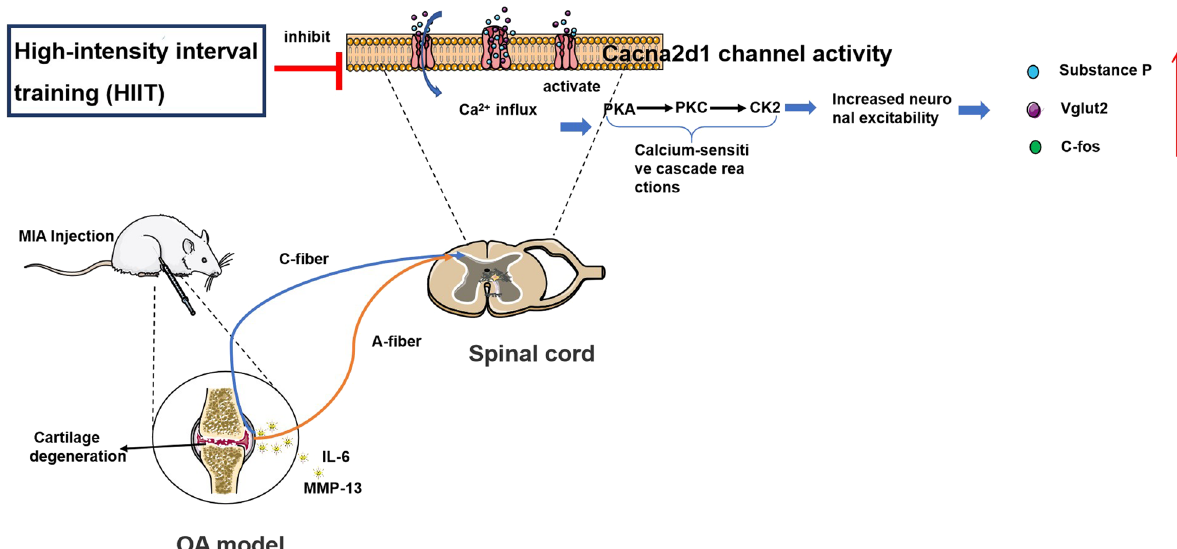
Fig. 4 Schematic illustration showing how intra-articular inflammatory mediators are delivered to the posterior horn of the spinal cord and finally cause pain sensitization. The nociceptive stimuli signals are transmitted to the posterior horn of the spinal cord through A fibers and C fibers, leading to increased Cacna2d1 channel activity. The increased influx of Ca 2 + further triggers a calcium-sensitive cascade, releasing pain neurotransmitters (Vglut2, SP, and c-fos). Neurons have higher excitability under the long-term infiltration of inflammatory mediators and pain neurotransmitters, which increases Ca 2 + influx and continuously releases pain neurotransmitters forming a vicious cycle reaction, leading to